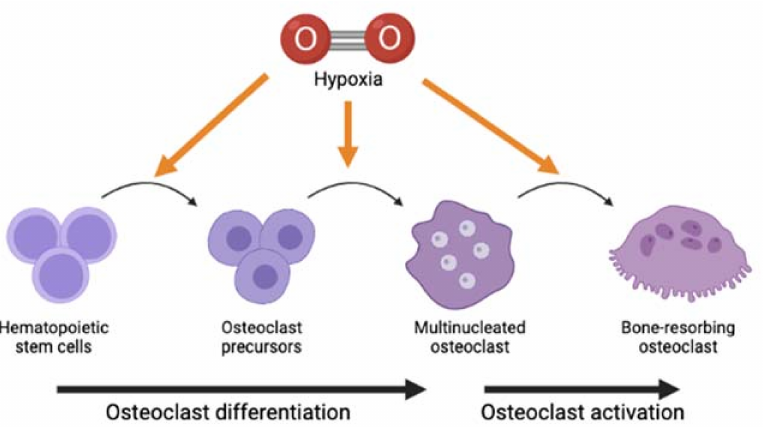
Figure 2. Graphical representation of possible stage(s) in osteoclast lifespan that hypoxia could affect, even though whether it either stimulates or suppresses the differentiation and activation of osteoclasts to resorb bone remains